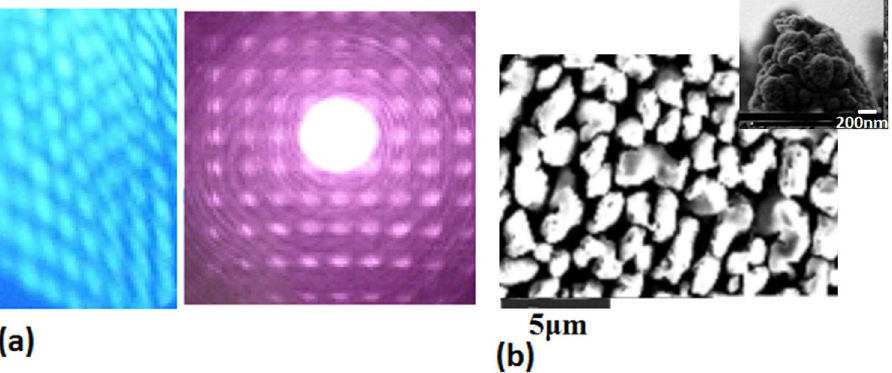
Figure 1. ( a ) In the PLE process, the plasmonic lattice structure induced by ns-laser as shown in the left optical image, and the diffraction pattern on the plasmonic lattice structure (similar with Wigner crystal structure) as exhibited in the right optical image; ( b ) The SEM image showing the pillars structure prepared by using ns-laser, where the inset exhibits the detail shape on the single tip of